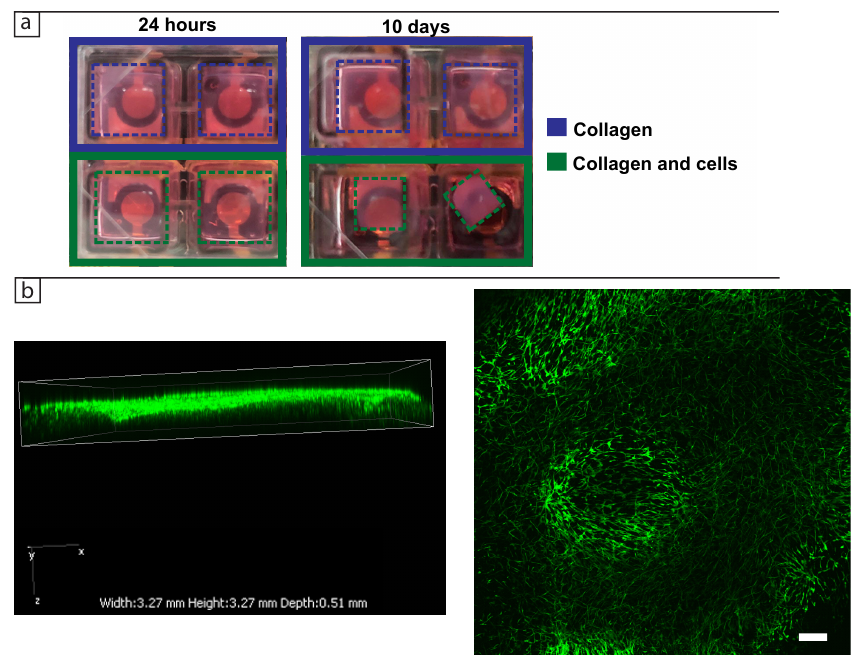
Figure 6. ( a ) Pictures of the wells seeded with 3 × 10 4 cells in collagen on the electrodes after 24 h ( left ) and 10 days ( right ). Blue dashed lines show the control samples containing only collagen in DMEM + FBS, while the green dashed lines show the samples containing cells in collagen and DMEM + FBS. ( b ) Confocal pictures of collagen seeded with 3 × 10 4 cells fixed after 10 days of culture and stained with phalloidin. ( left ) Side view of 3D confocal volume and ( right ) maximum intensity projection in the XY plane. Scale bar represents 250 µ